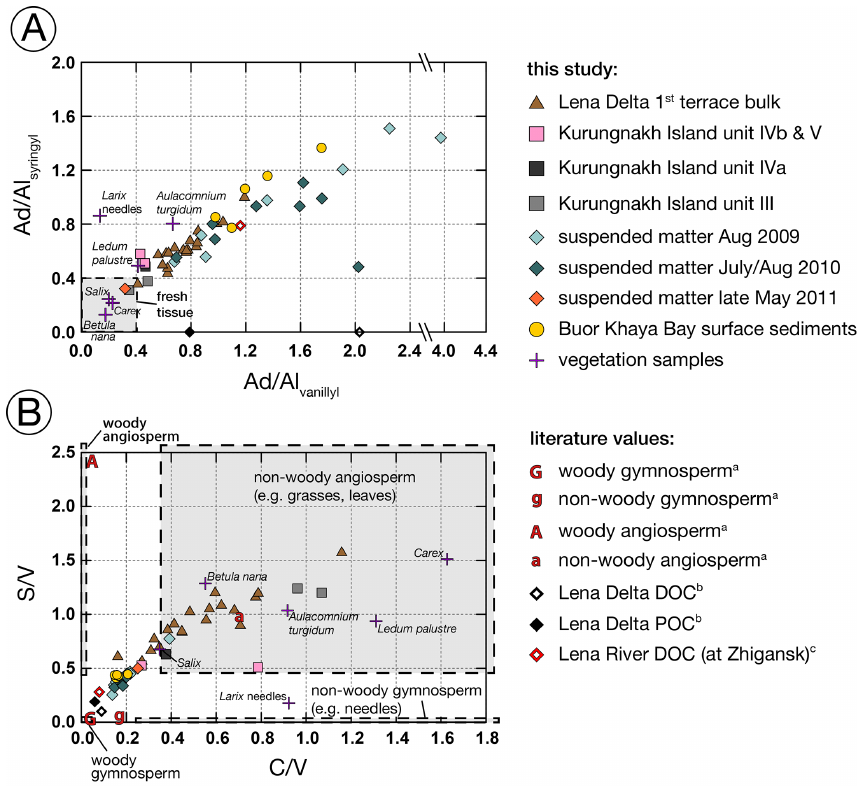
Figure 4. (a) Lignin degradation indices (Ad / Al V vs. Ad / Al S ) and (b) vegetation source parameters (C / V vs. S / V) including compo- sitional ranges of major vascular plant types (Goñi et al., 1998; Goñi and Hedges, 1992; Hedges and Mann, 1979; Hu et al., 1999). For abbreviations see Fig. 3. Note the different scales. Literature values: a end-member values used in this study taken from Table 4 in Amon et al. (2012) and references therein, b Lobbes et al. (2000), c Amon et al. (2012). Note that, in (a) , there are two values on the Ad / Al V